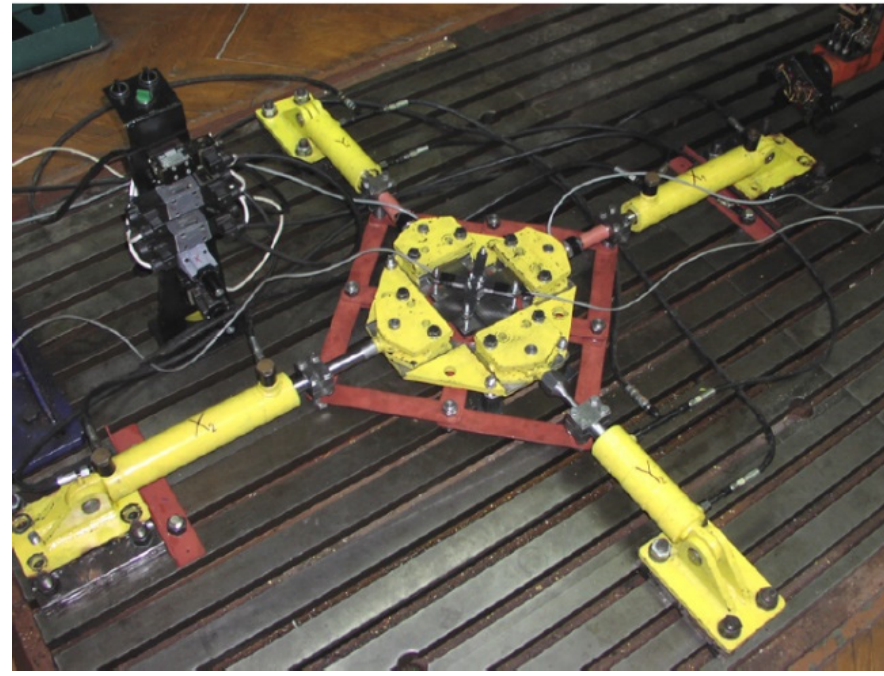
Figure 5. Overall view of the experimental device in the biaxial tensile test.